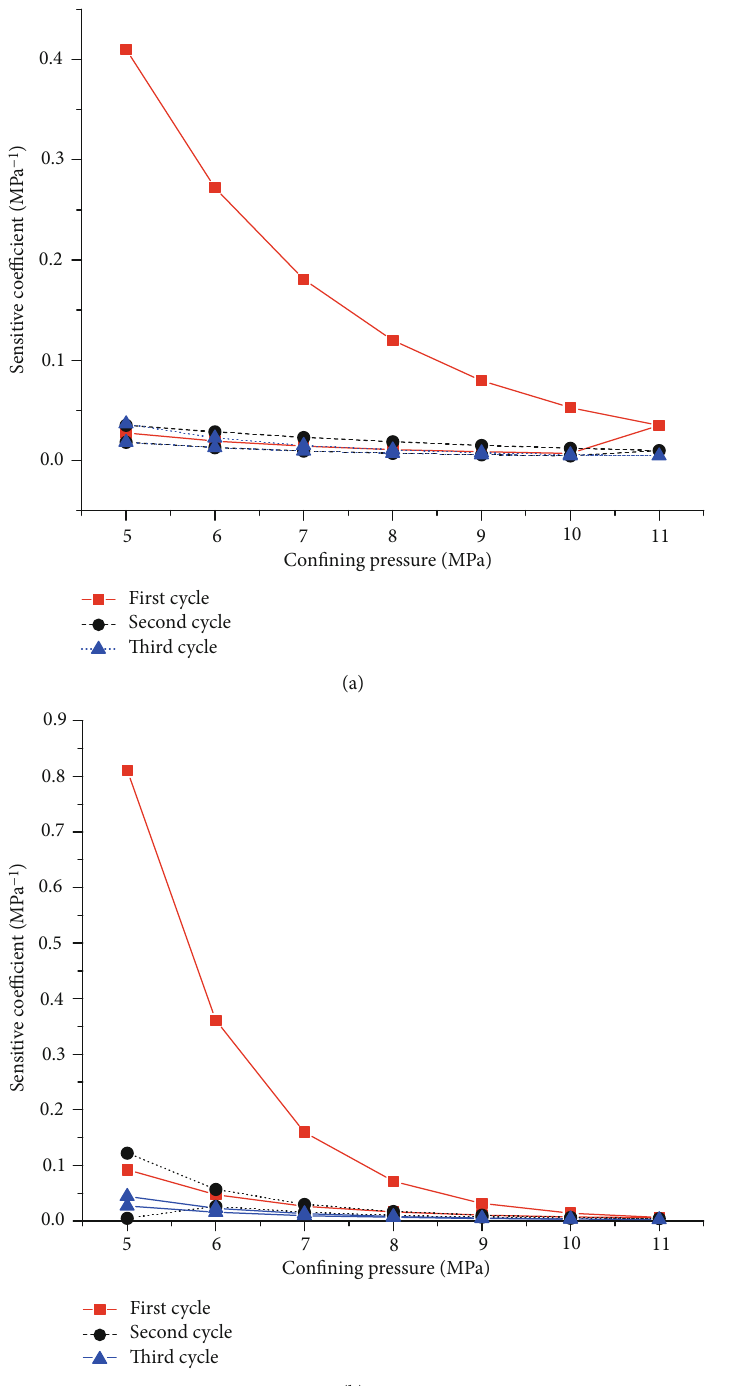
Figure 8: Permeability-stress-sensitive coe ffi cient of reservoir shale with di ff erent hydrated days. The labels in Fig.8 is as follows, (a) No hydration (b) 10